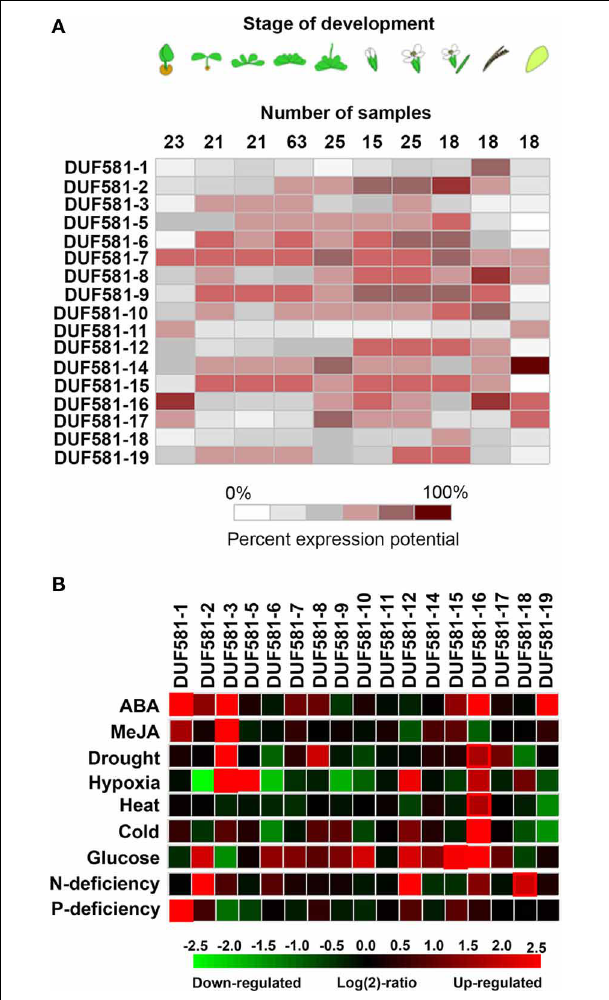
FIGURE 2 | Heat map comparing expression of Arabidopsis DUF581 protein encoding genes using microarray data available in the Genevestigator database (Hruz et al., 2008). (A) Developmental time course of DUF581 gene expression in Arabidopsis . Datasets derived from the analysis of tissue-specific gene expression or developmental time courses of Col-0 plants were used for the meta-analysis. (B) Impact on different perturbations on DUF581 expression level. ABA; excised leaf samples of 5 weeks old Arabidopsis thaliana Col-0 wild-type plants were treated with 50mM ABA for 3h (experiment ID AT-000433). MeJa; Cell samples of T87 cell suspension that was grown under 16h light/8h dark cycles were exposed to 100 μ M MeJa (methyl jasmonate) for 24h (experiment ID-AT000539). Drought; green tissues of treated seedlings were harvested 24h after onset of treatment (experiment ID AT-000419). Heat; seedling samples of Col grown for 11 days on peat pellets at 21 ◦ C were transferred to 40 ◦ C for 1h (experiment ID AT-000645). Cold; 16-day old seedlings were transferred to 4 ◦ C under low light and green tissues were harvested after 24h (experiment ID AT-00120). Glucose; seedling samples of Col grown for 5 days on solid medium (0.5x Murashige and Skoog (MS) salts, 1% sucrose, 0.8% agar) were washed seven times with water and once with liquid medium (0.5x MS salts), incubated for 24h in liquid medium and then incubated in liquid medium containing 3% glucose and for 3h in darkness (experiment ID AT-000650). N-deficiency; seedling samples of Col-0 grown in sterile liquid medium with 4mM KNO 3 (N-replete condition) for 7 days and then for 2 days in medium with no N added (N-deplete condition) (experiment ID